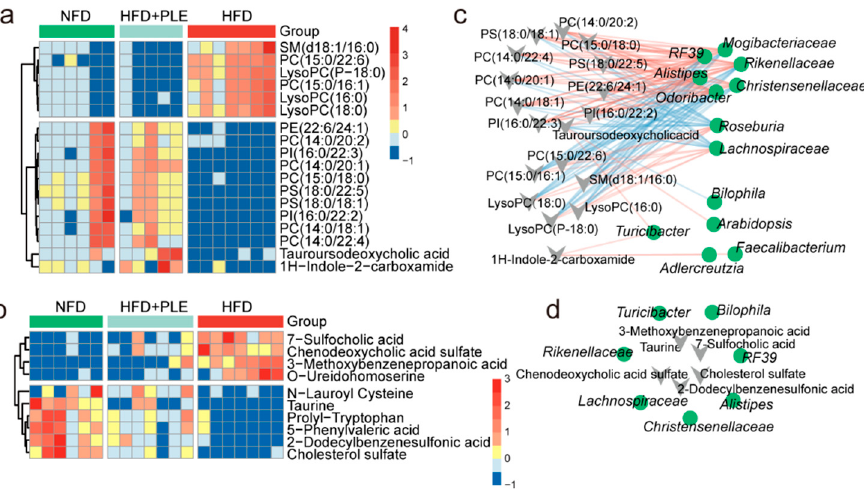
Figure 2. PLE prevents HFD-induced NAFLD associated with metabolites. ( a ) Heatmap visualizing the changes in the contents of overlapping biomarkers in the serum of the NFD, HFD and HFD+PLE groups (n = 5~7). ( b ) Heatmap visualizing the changes in the contents of overlapping biomarkers in the feces of the NFD, HFD and HFD+PLE groups (n = 6~7). ( c ) Spearman correlation analysis between the 14 genera found by Lefse between the HFD and HFD+PLE groups and serum metabolite biomarkers in mice in the NFD, HFD and HFD+PLE groups. ( d ) Spearman correlation analysis between the 14 genera found by Lefse between the HFD and HFD+PLE groups and fecal metabolite biomarkers in mice in the NFD, HFD and HFD+PLE groups. p values were calculated using the Wilcoxon rank-sum test and corrected by the method described by Benjamini and Hochberg. NFD: treatment with a normal-fat diet; HFD: treatment with a high-fat diet; NFD+PLE: treatment with a normal-fat diet and 150 mg/kg polyphenol-rich Liupao tea extract; HFD+PLE: treatment with a high- fat diet and 150 mg/kg polyphenol-rich Liupao tea extract.